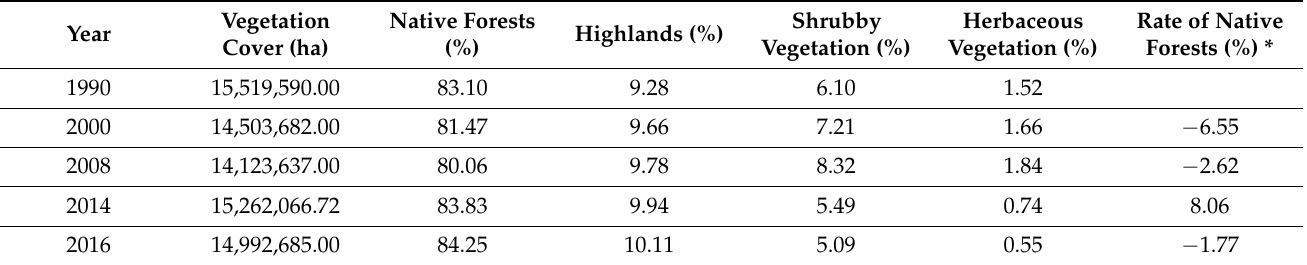
Table 2. Vegetation cover of Ecuador by category and rate of native forests